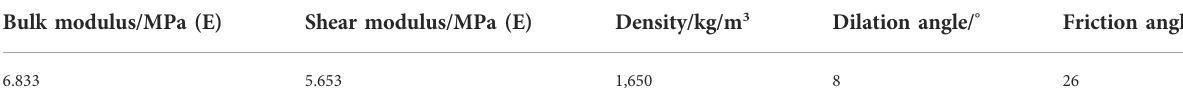
TABLE 2 Mechanical parameters of the double yield model in goaf of the 8202 working